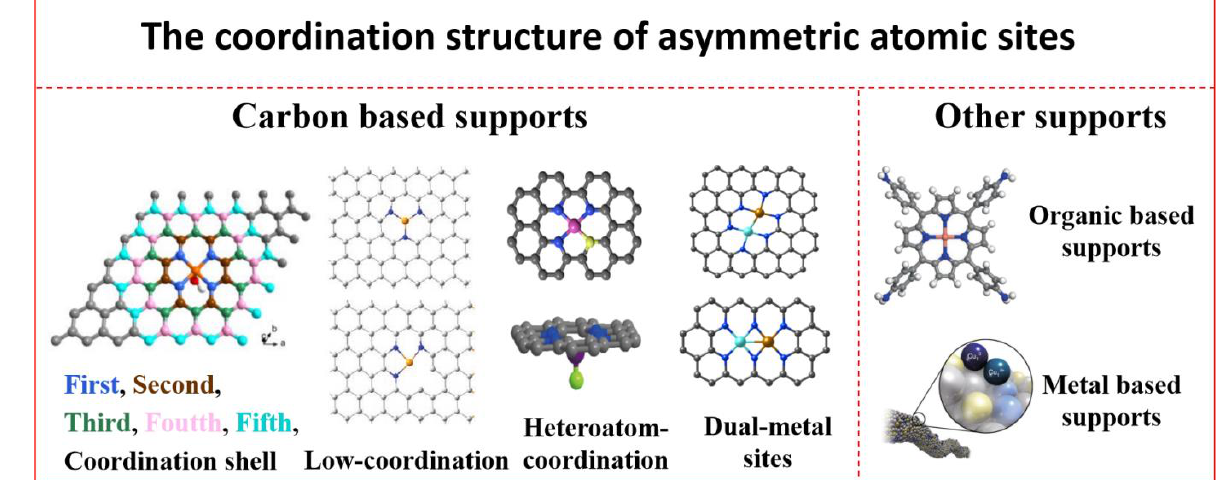
Figure 1. Model diagrams of symmetric and asymmetric atomic configurations. (The heteroatom coordination (bottom) elements are reprinted with permission from ref. [56], copyright: (2019) Nature Publishing Group; the organic-based support elements are reprinted with permission from ref. [57], copyright: (2021) Nature Publishing Group; other elements are taken from Figures 2–7.)